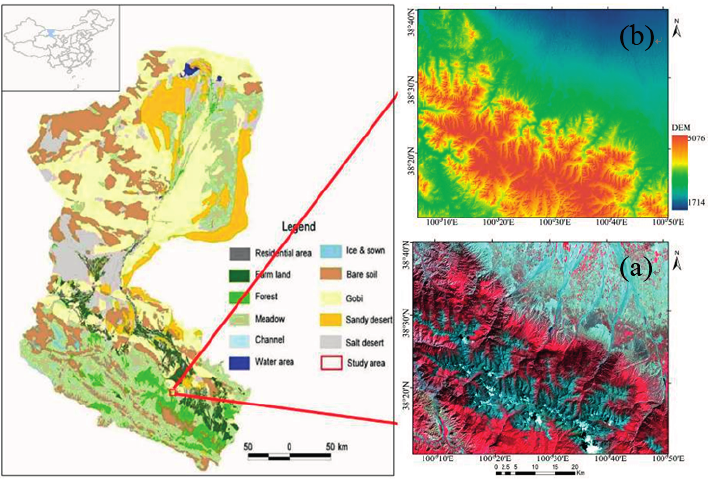
Figure 3. Details of the study area based on a ( a ) DEM and ( b ) false-color composite (RGB: band 4, 3 and